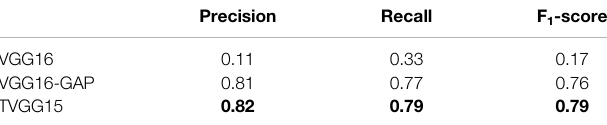
TABLE 2 | Model training